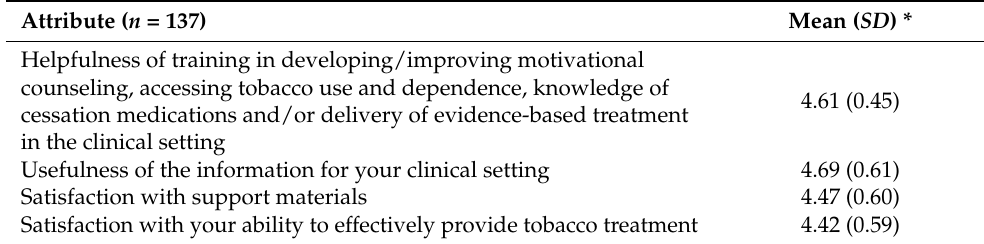
Table 3. Post-training